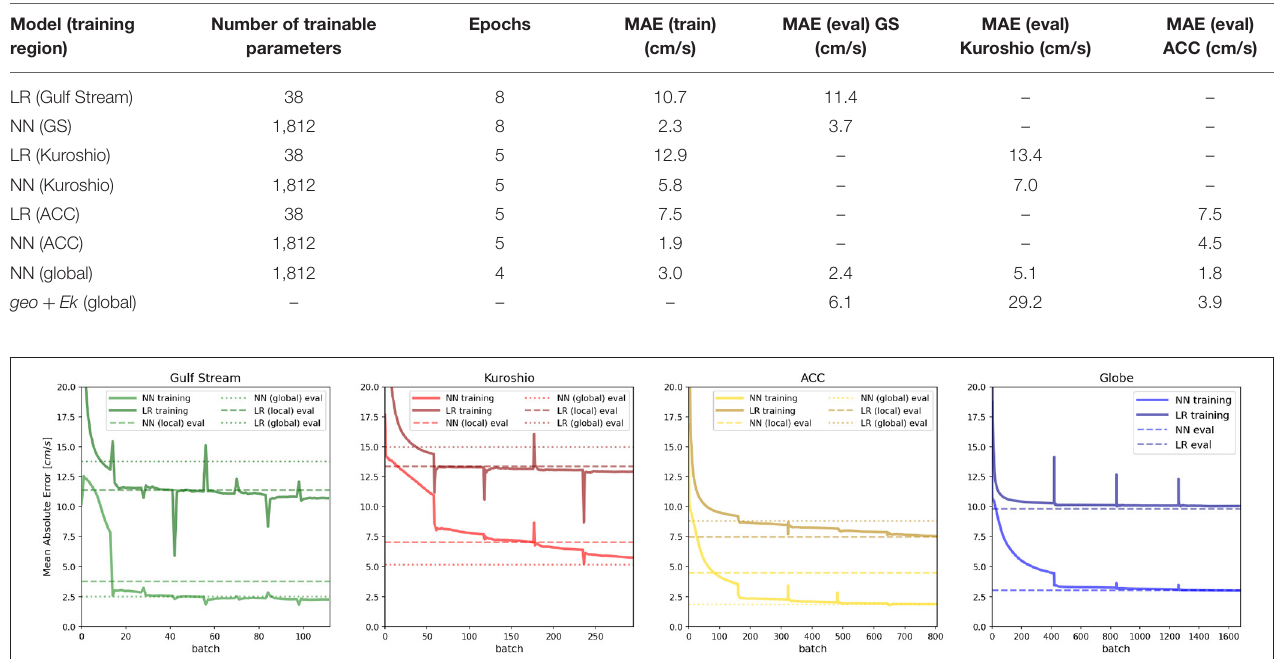
TABLE 1 | Table summarizing model errors from the physics based model (geostrophy + Ekman flow) and the two types of regression models—linear regression and neural network ( Figures 1A,B ). Model (training region)